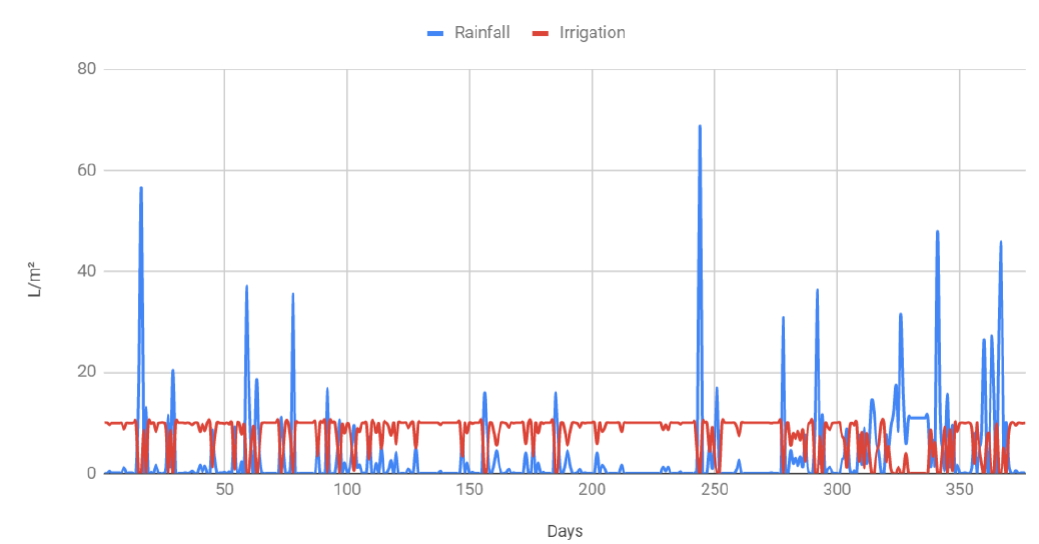
Figure 6. Estimated irrigation per day during a year when depending on rain forecasts.